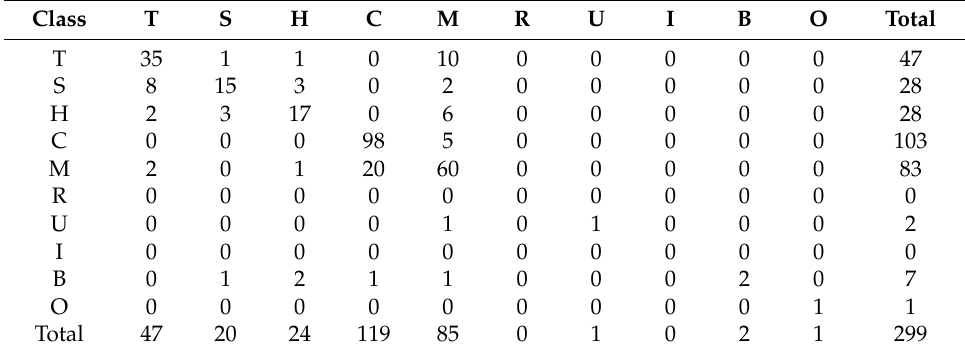
Table 3. Confusion matrix for the benchmark classification of Scenario 1; columns show the class label in the reference data set and rows the label determined in the scenario.